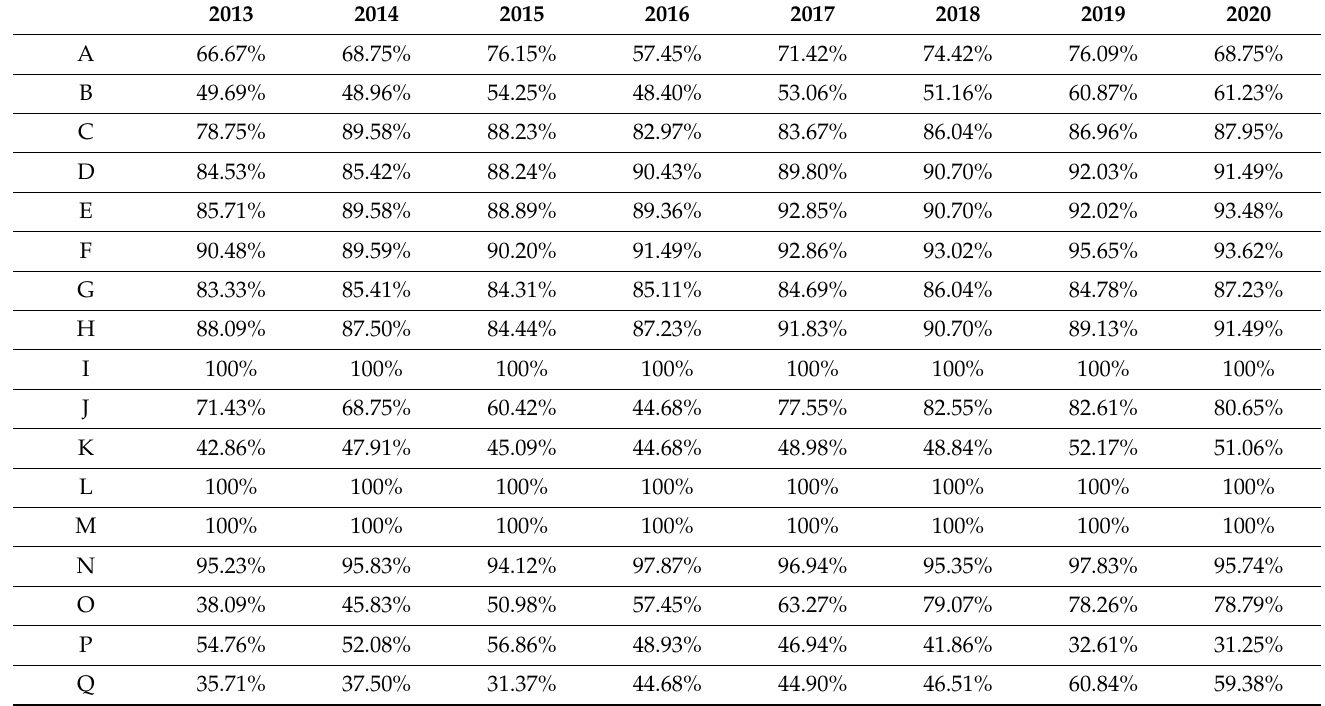
Table 1. Percentage of correctly conducted procedures carried out by MRT members during the Championships in the years